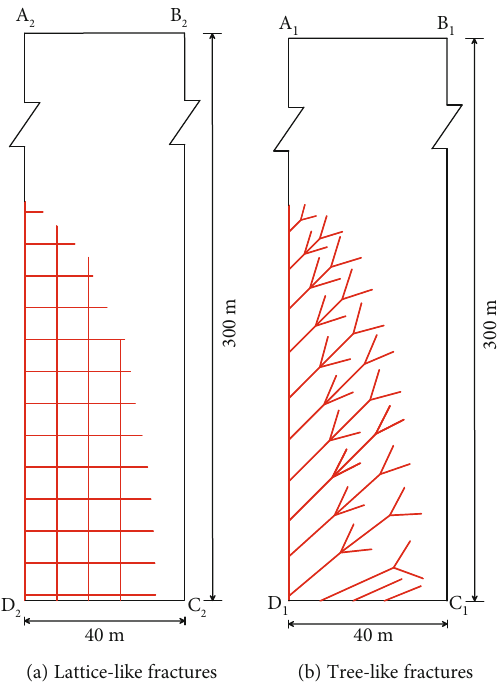
Figure 2: Geometric models of lattice-like and tree-like fractures.